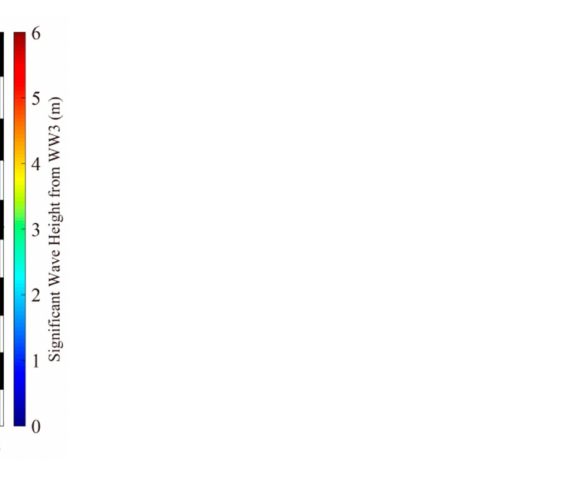
Figure 5. The significant wave height (SWH) data obtained from the WAVEWATCH-III (WW3) model at 18:00 UTC on 5 July 2015, overlaid with the footprints of the Jason-2 altimeter. Table 1. The basic settings for the WAVEWATCH-III (WW3) model and the Stony Brook Parallel Ocean Model (sbPOM). Forcing Fields Output Resolution Open Boundary Conditions Winds composited using the European Centre for Medium-Range Weather Temporal resolution of 30 min and WW3 / Forecast (ECMWF) data and a spatial grid resolution of 0.1 ◦ parametric Holland model (H-E) National Centers for H-E winds; Simple Ocean Data Environmental Prediction Assimilation (SODA) sea surface (NCEP) latent heat flux Temporal resolution of 30 min and temperature and salinity sbPOM NCEP sensible heat flux spatial grid resolution of 0.25 ◦ Wave-induced: breaking wave; NCEP long-wave radiation nonbreaking wave Radiation stress; stokes drift NCEP short-wave